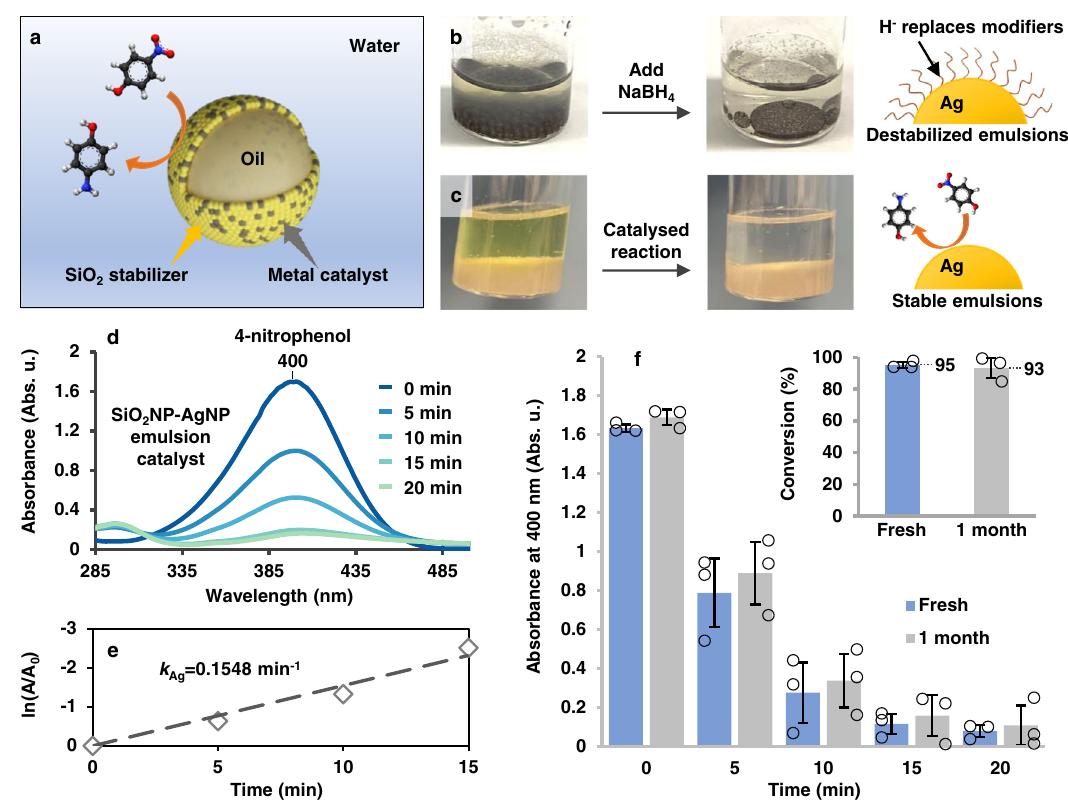
Fig. 6 | Interfacial catalysis with o/w SiO 2 NP-AgNP Pickering emulsions. a Schematic illustrations of a modi fi er-free o/w SiO 2 NP-metal NP emulsion droplet acting as an interfacial catalyst for the reduction of 4-nitrophenol to 4-aminophenol. b Optical images of a Ag emulsion sample formed with 3-MPA modi fi ers before and a few minutes after being treated with NaBH 4 solution. Also shownisthe schematicillustrations of the 3-MPA modi fi ersbeing replaced byH - in the NaBH 4 solution leading to emulsion destabilization. c Optical images of a SiO 2 NP-AgNP emulsion sample before and after 20min of catalytic reaction. Also shown is the schematic illustrations of the surface-accessible AgNPs in modi fi er- free emulsions acting as stable catalysts. d UV – vis spectra of 4-nitrophenol